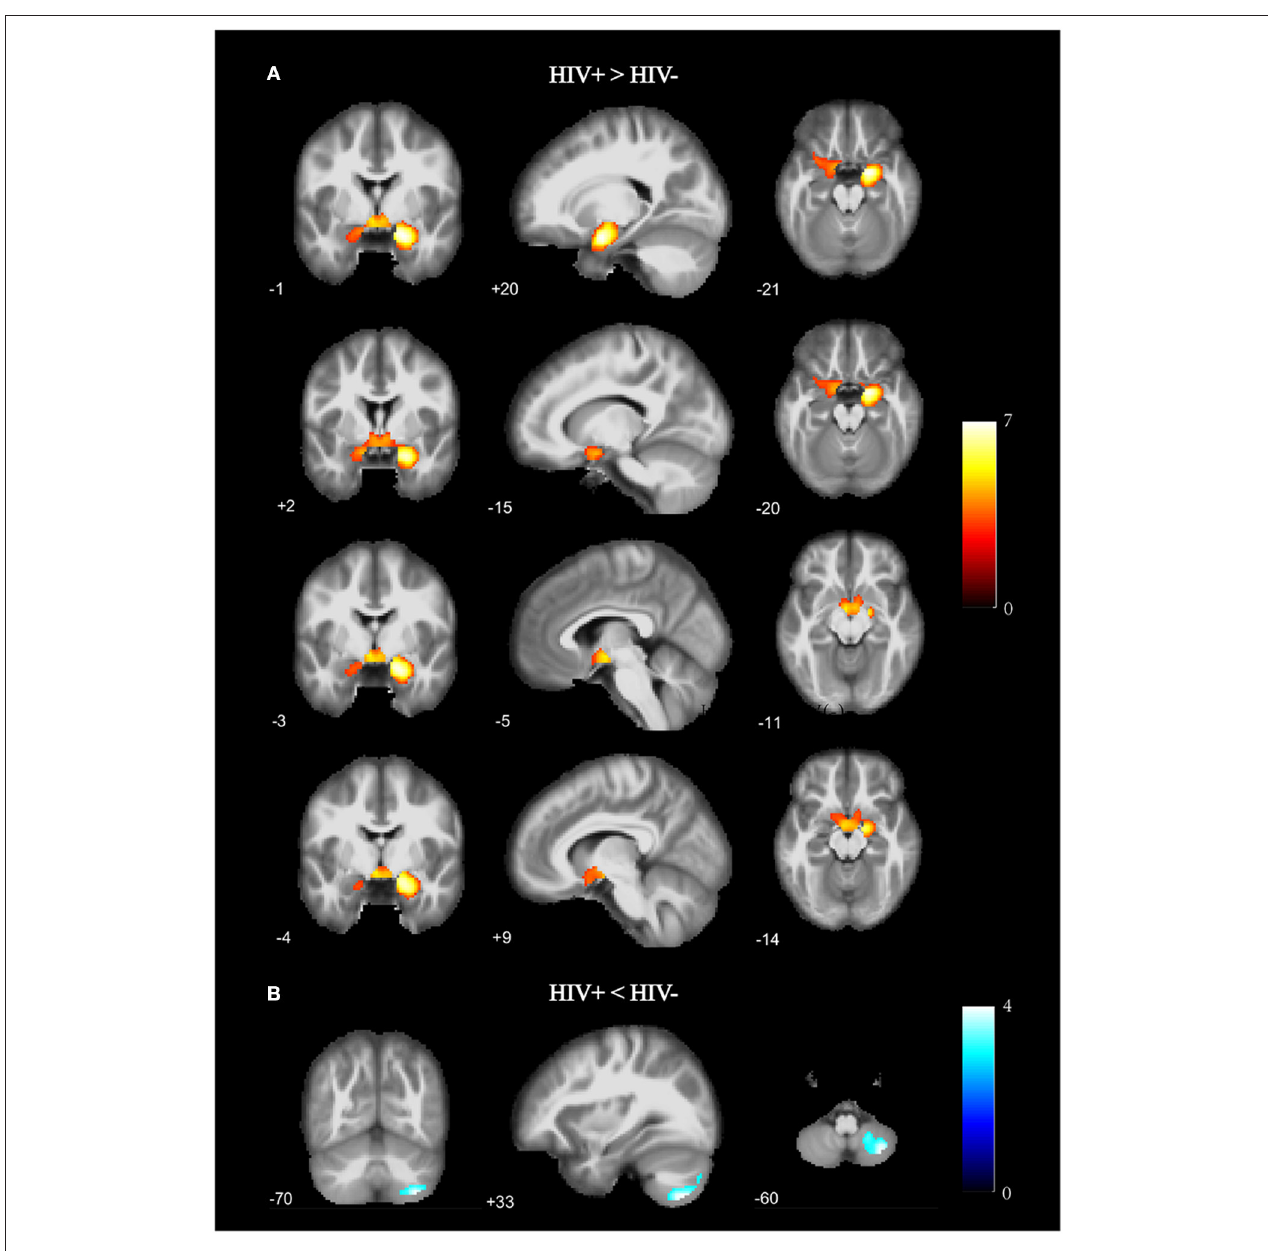
FIGURE 1 | Gray matter volume (GMV) differences between HIV + HoM and HIV– HoM based on voxel-based morphometry (VBM) analysis. (A) Brain regions with significantly increased gray matter in the HIV + HoM group (voxel-level uncorrected P < 0.001, cluster-level FWE-corrected P < 0.05). (B) Brain regions with significantly decreased gray matter in the HIV + HoM group (voxel-level uncorrected P < 0.001, cluster-level FWE-corrected P < 0.05). The color bars indicate T -statistics.